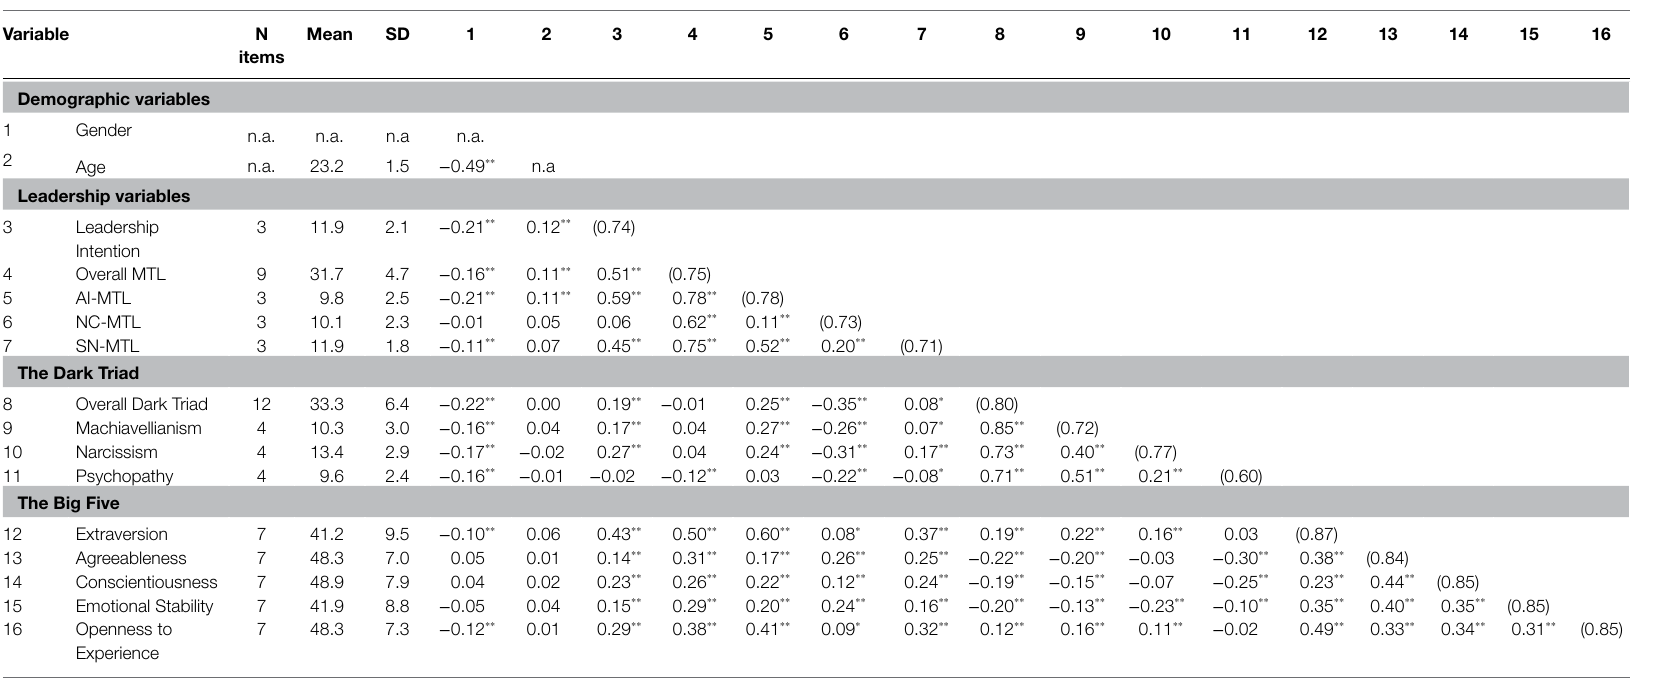
TABLE 1 | Scale descriptive statistics, reliabilities (in diagonals), and inter-scale correlations.